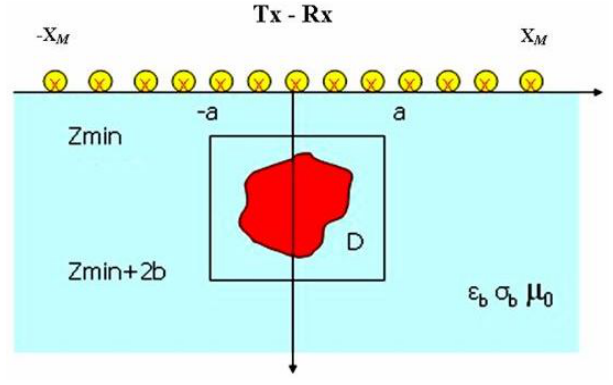
Geometry of the two-dimensional inverse scattering